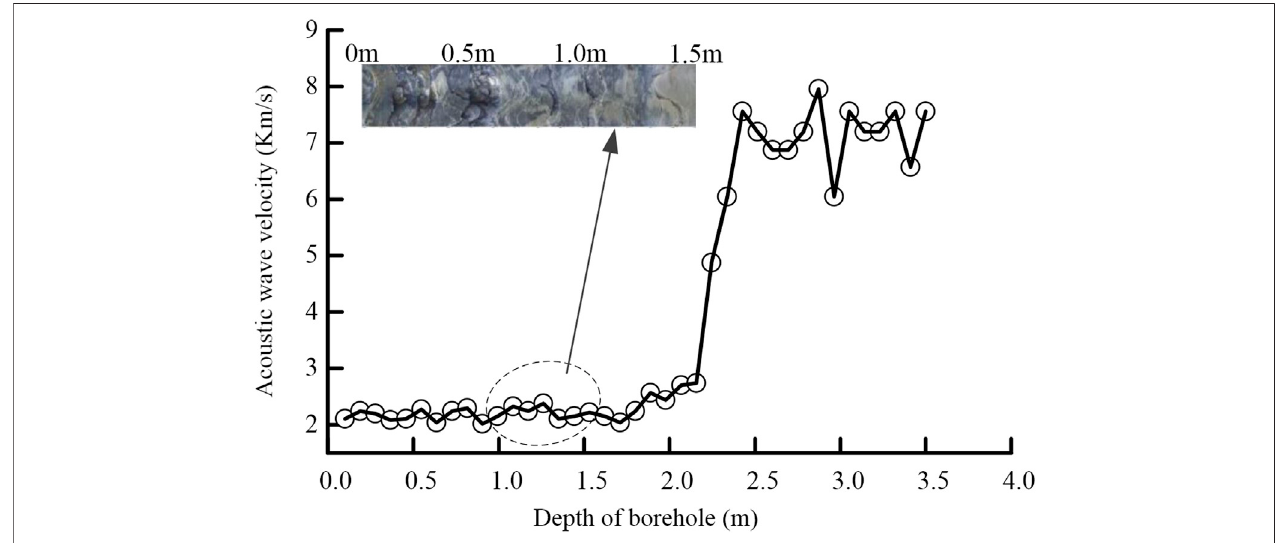
FIGURE 4 | Visible fracture of rock mass from digital borehole